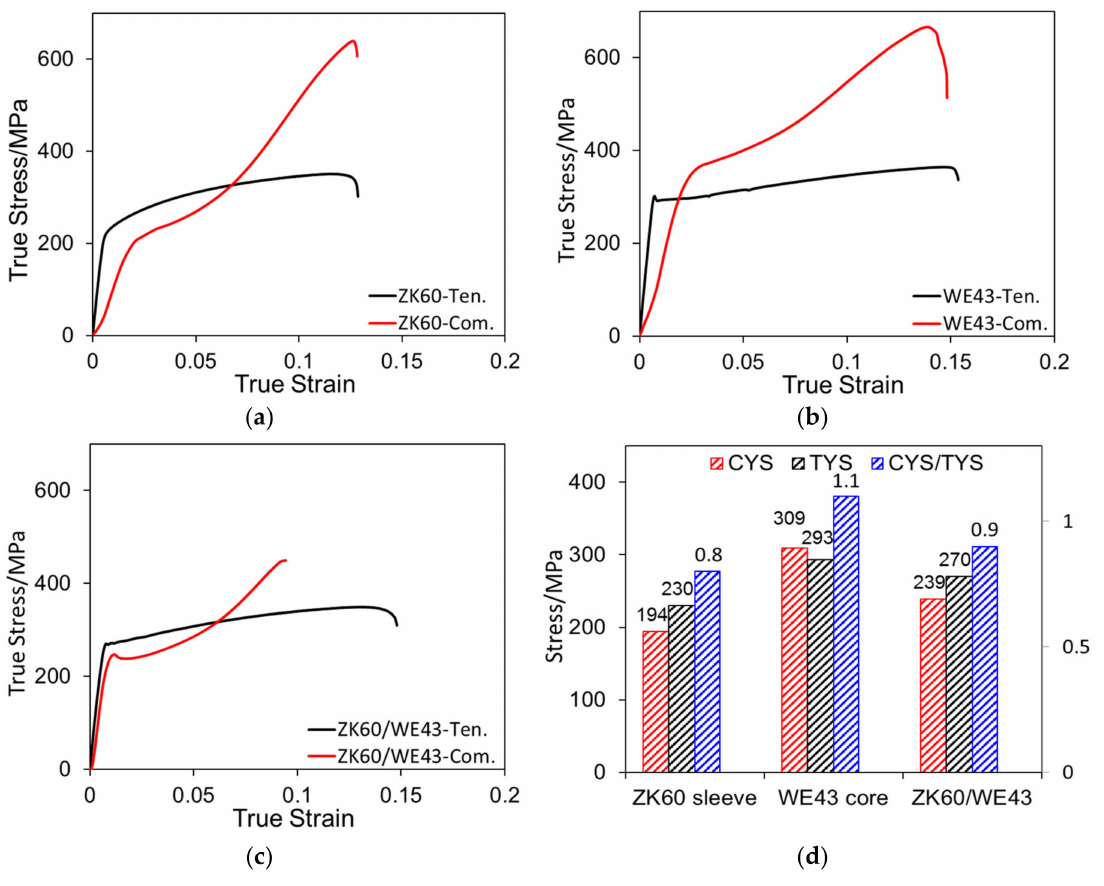
Figure 4. True tensile and compressive stress-strain curves of ( a ) ZK60 sleeve, ( b ) WE43 core, and ( c ) ZK60 / WE43 bimetal composite along the extrusion direction. ( d ) Yield strength of the ZK60 sleeve, WE43 core, and ZK60 / WE43 bimetal composite under compression and tension along the extrusion direction. Here Ten. and Com. represent the tension and compression, respectively, and CYS and TYS denote the compressive yield strength and the tensile yield strength,